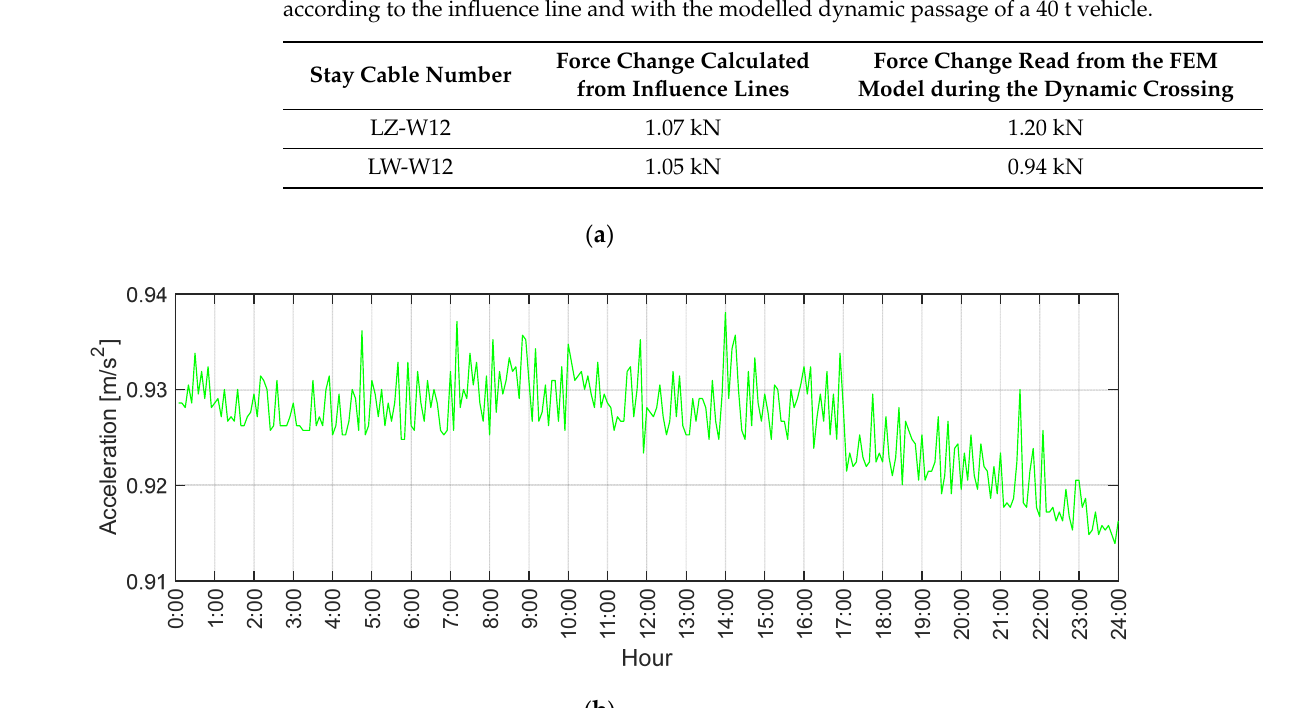
Table 9. Comparison of tension force changes in one strand of LZ-W12 and LW-W12 cables calcu- lated according to the influence line and with the modelled dynamic passage of a 40 t vehicle.